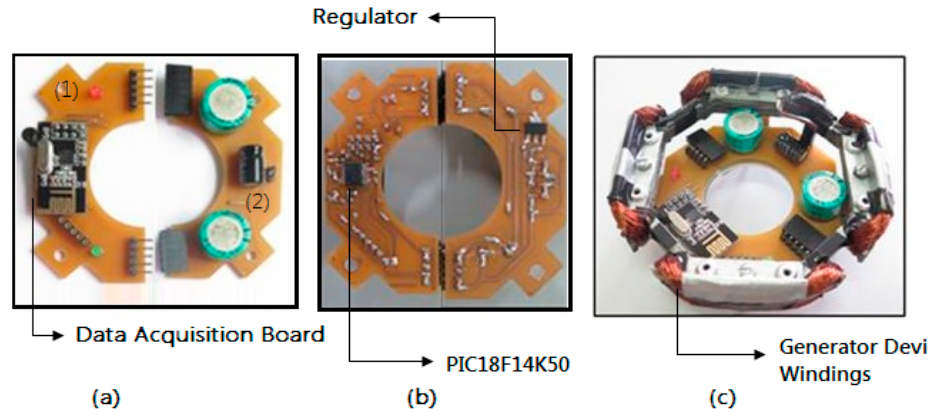
Figure 8. PCBs. ( a ) Top view; ( b ) bottom view; ( c ) PCBs set on generator device.